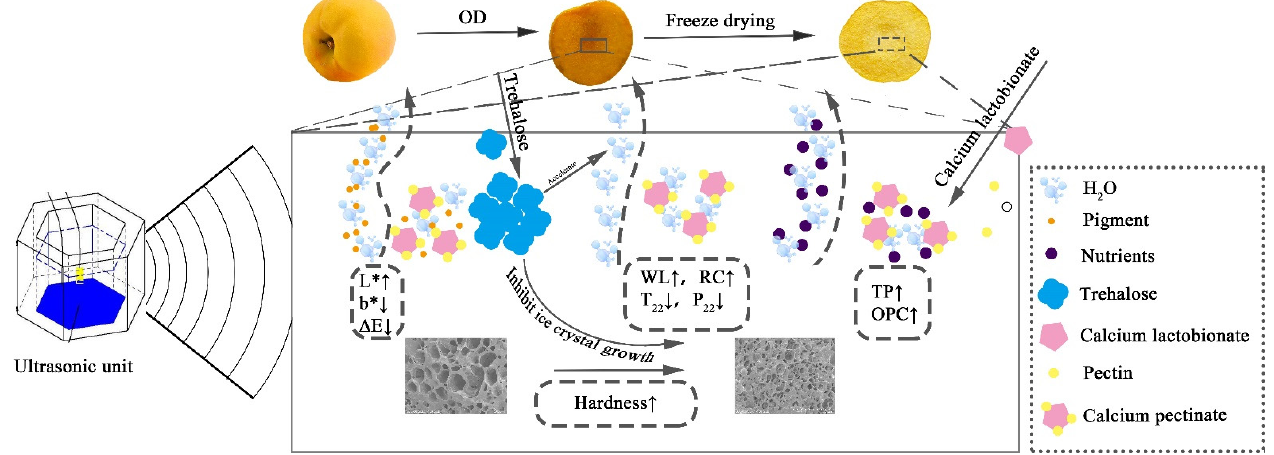
Figure 6. Schematic diagram of the mechanism by which ultrasonic-assisted osmotic dehydration pretreatment affects the quality of freeze-dried yellow peach slices.